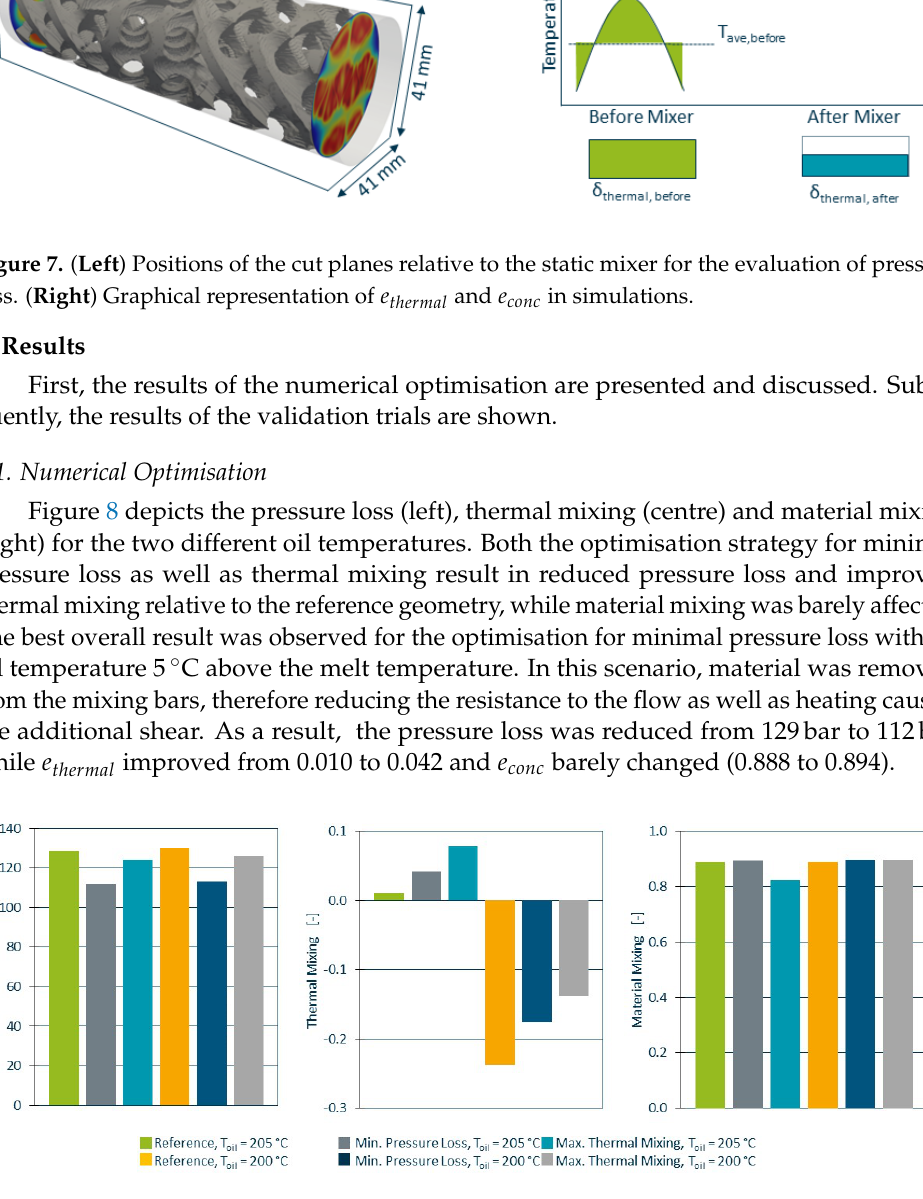
Figure 8. Pressure loss ( left ), thermal mixing ( centre ) and material mixing ( right ) for all simulations. Best results are seen for the higher oil temperature and optimisation for minimal pressure